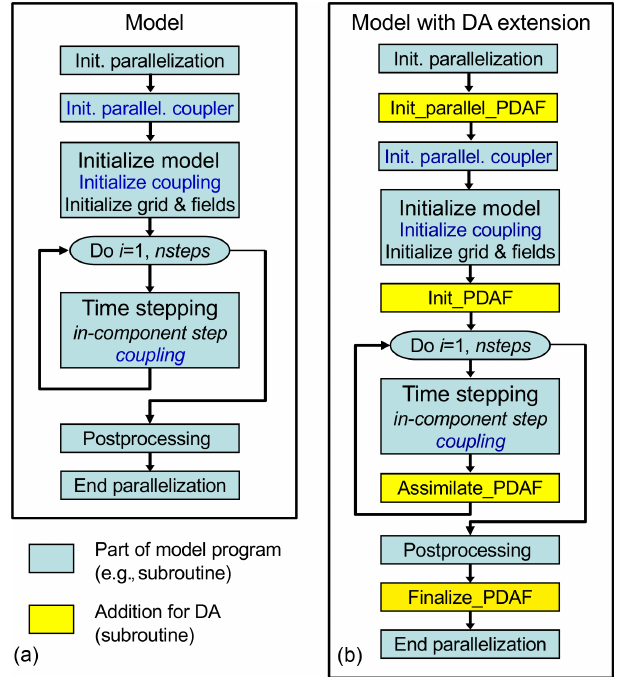
Figure 2. General program flow: (a) abstract original program with- out data assimilation; (b) program augmented for data assimila- tion. The blue color marks coupling routines whose parallelization needed to be adapted for the data assimilation. Each of the two cou- pled compartment models were augmented in this